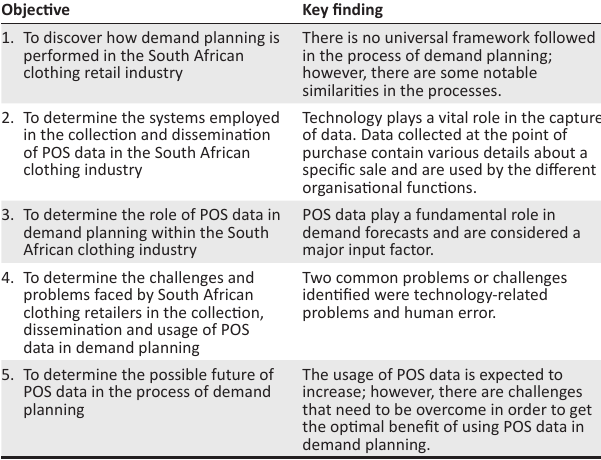
TABLE 2: Key findings and their relationship with the research